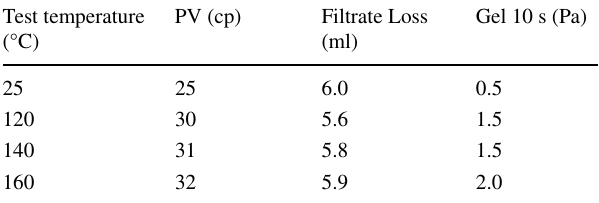
Table 10 Mud properties at various temperatures